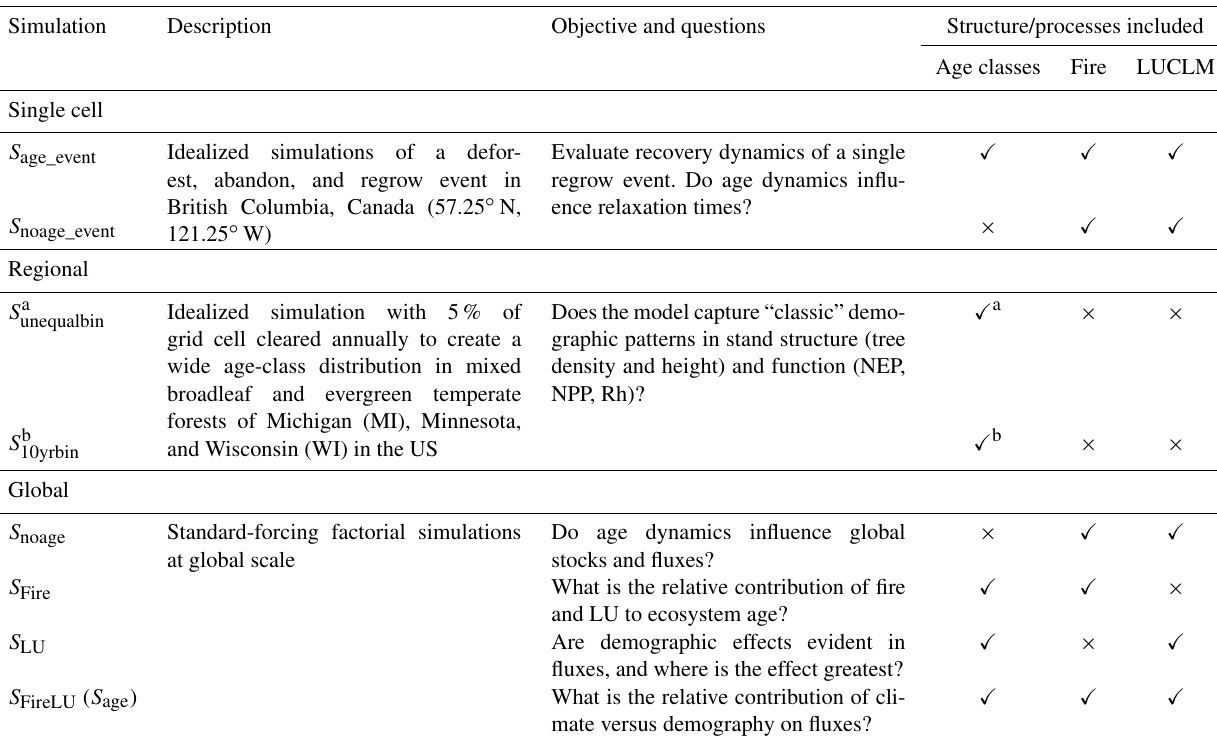
Table 2. Description of LPJ-wsl v2.0 simulations in this study, corresponding objectives and related science questions. Simulation Description Objective and questions Structure/processes included